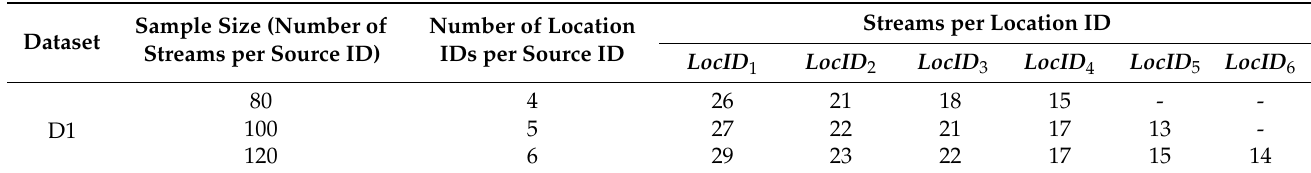
Table 5. The distribution of the streams of service 1 as per the location IDs at sample sizes of 80, 100 and 120 before aggregation for dataset D1.